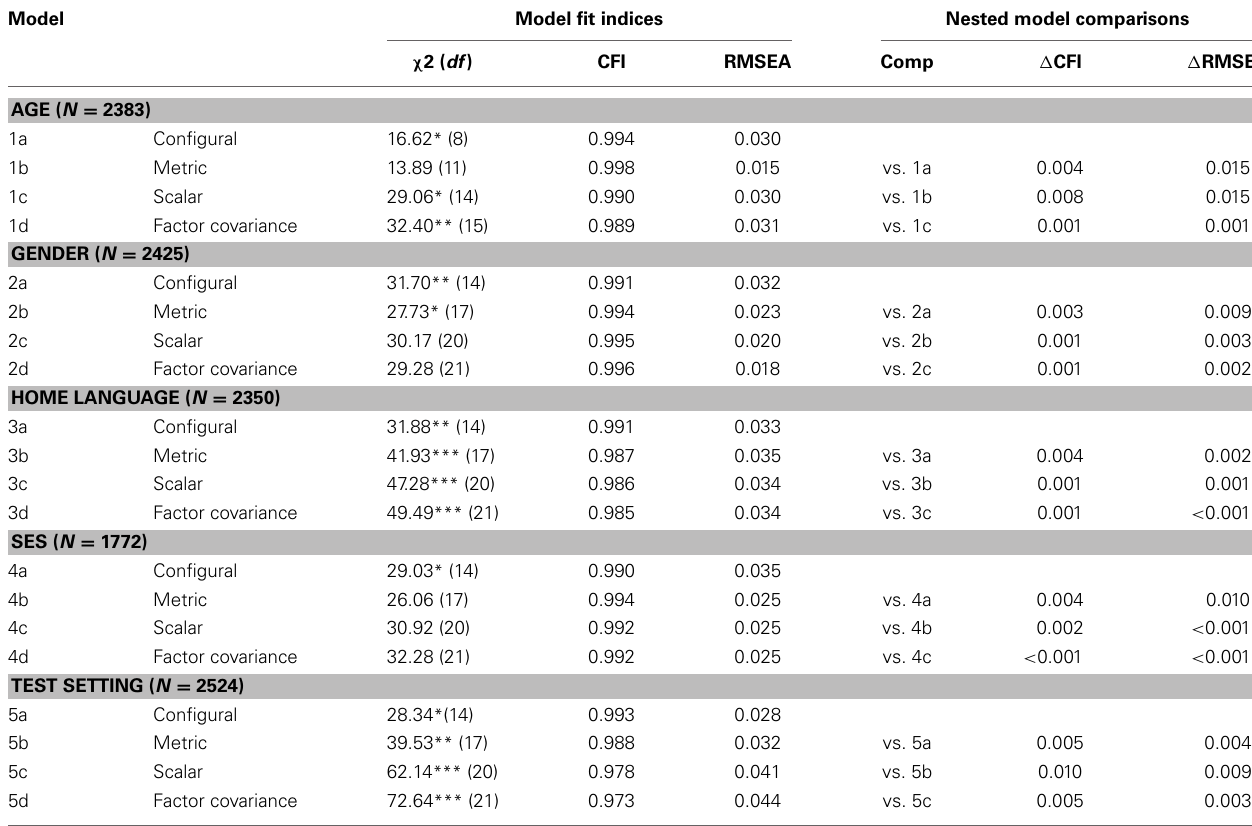
Table 4 | Analysis of measurement invariance across